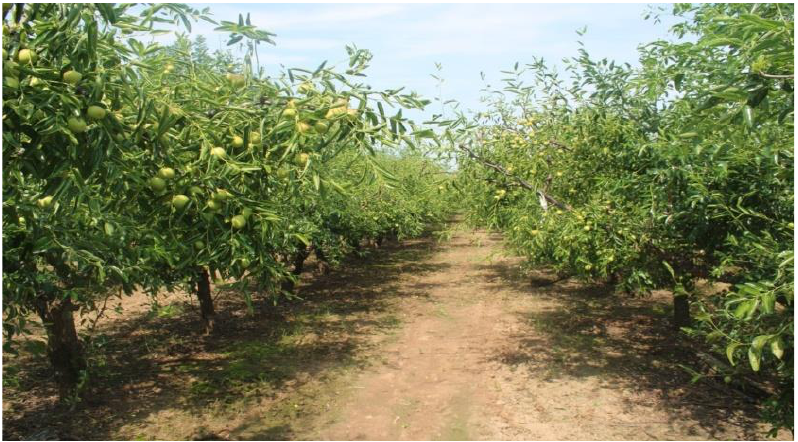
Figure 1. The typical jujube orchard selected in this study.